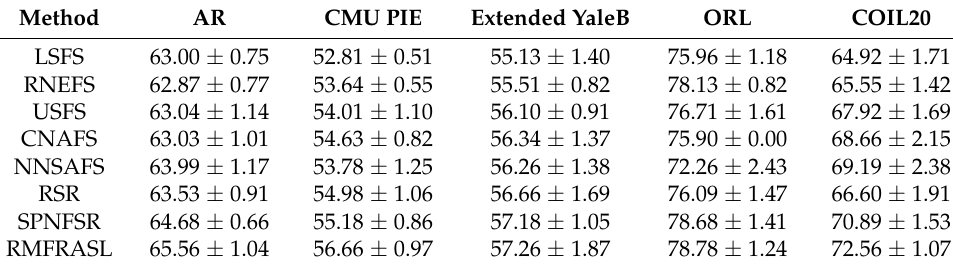
Table 10. The best NMI % and STD of different algorithms on the five databases.